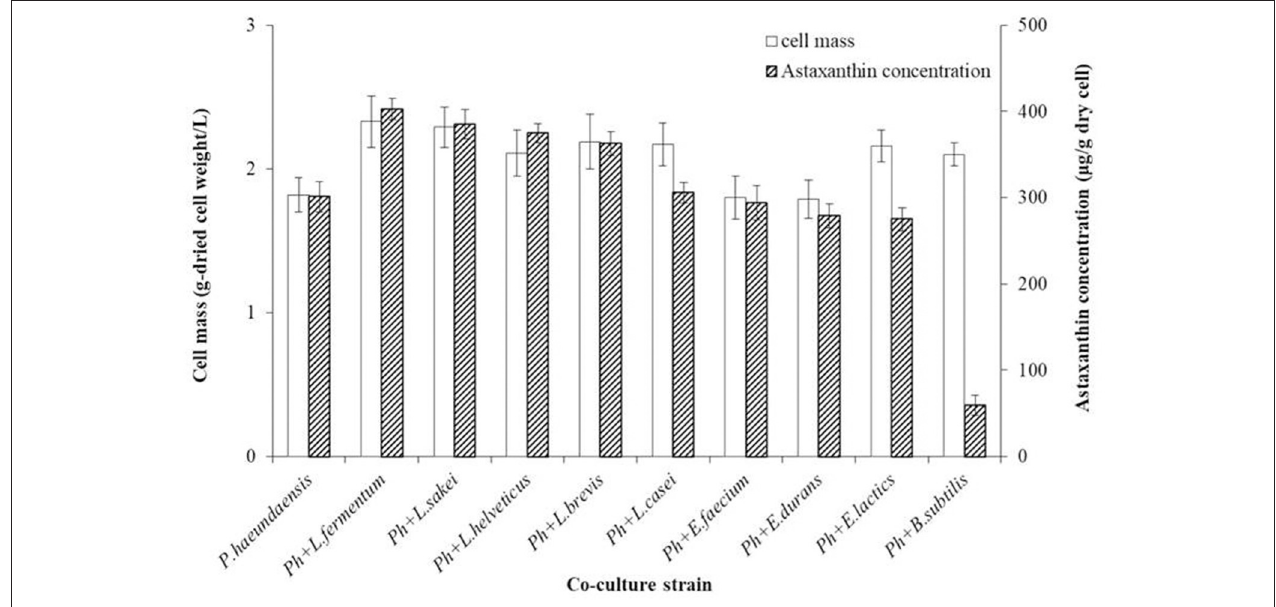
FIGURE 2 | Comparison of cell mass and astaxanthin concentration by co-culture of Paracoccus haeundaensis and lactic acid bacteria.